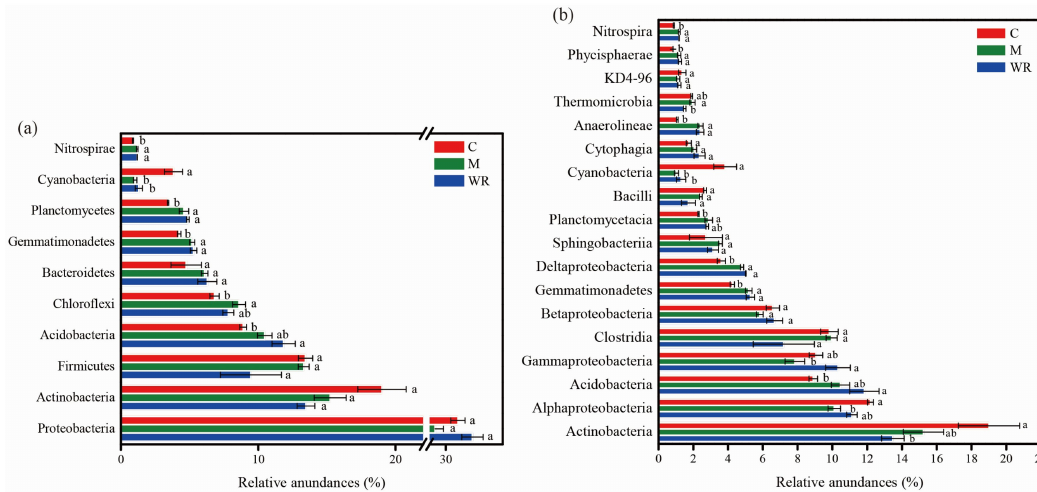
Figure 4. Relative abundances of main bacterial phyla ( a ) and classes ( b ) in cucumber rhizosphere. Bacterial phyla and classes with average relative abundances >1.0% in at least one treatment were shown. C, M and WR represent treatments of cucumber monocropping, rotations with Indian mustard and wild rocket, respectively. Different letters indicate statistically significant differences among treatments (Tukey’s HSD, p <